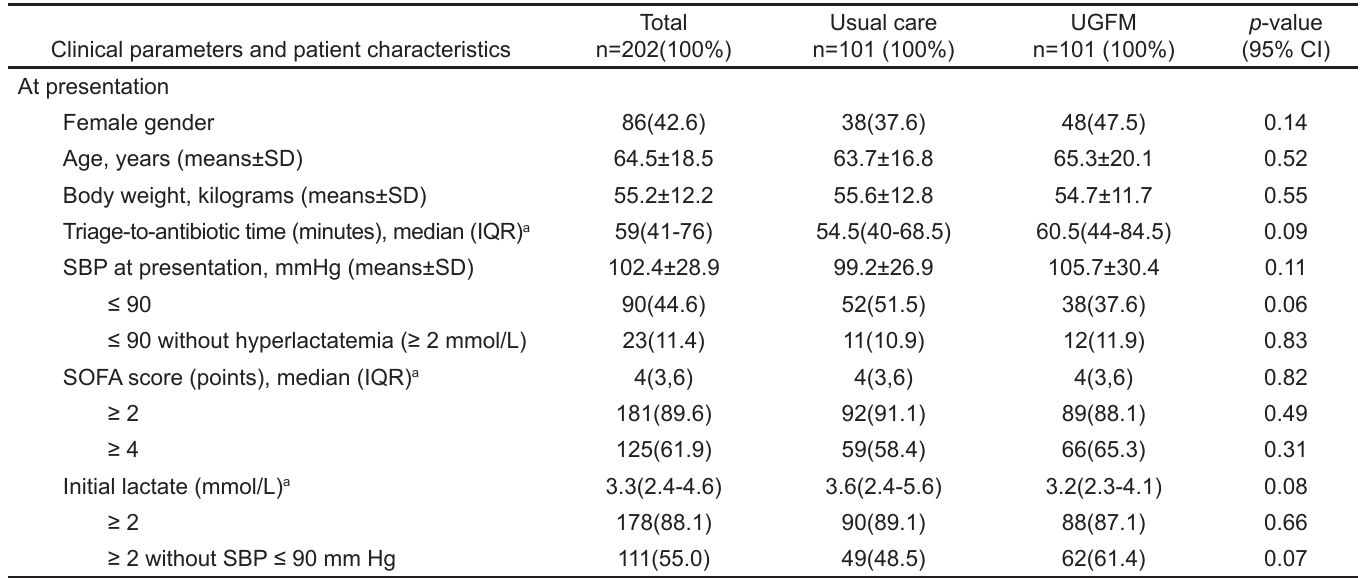
Table 1. Demographic data of the patient cohort.